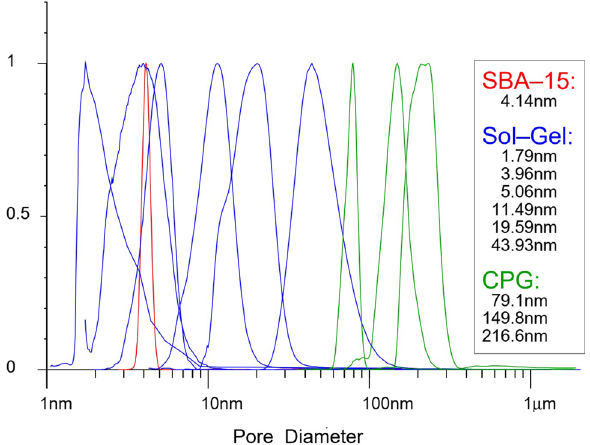
Fig. 22 Normalised pore-size distributions, measured using NMR cryoporometry, using the established kGT value, for a range of porous sol-gel silicas, controlled-pore glasses, and a templated SBA-15 silica